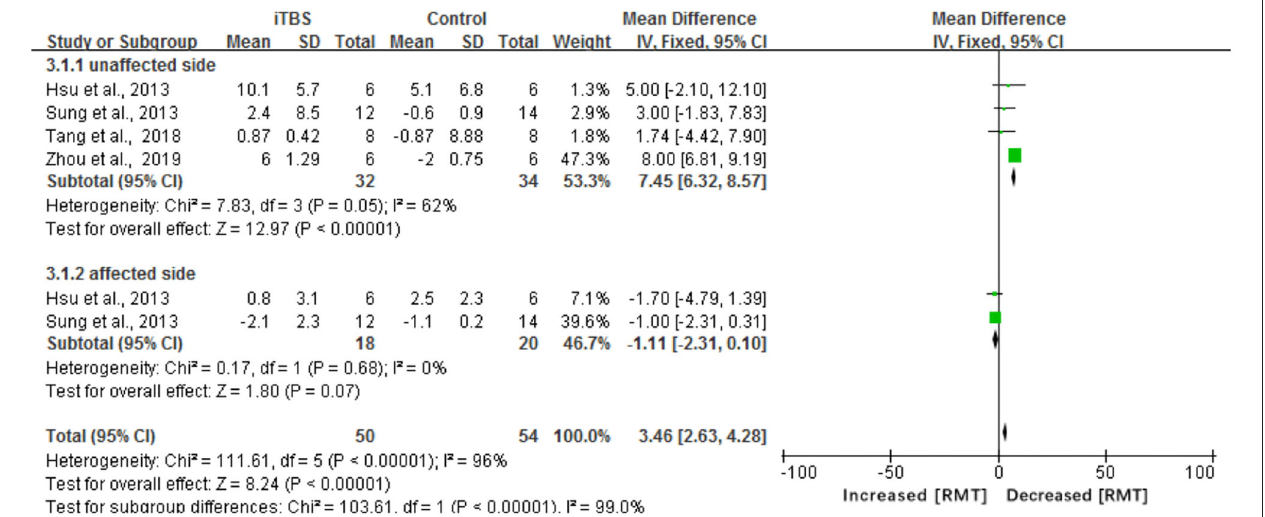
FIGURE 7 | Forest plots of the pooled results on RMT.